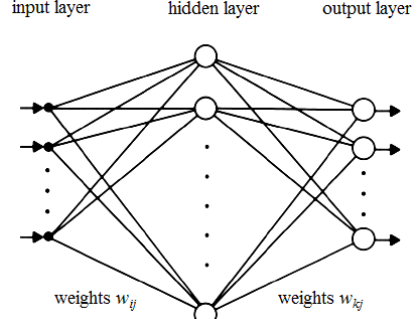
Figure 1. Three-layer neural network